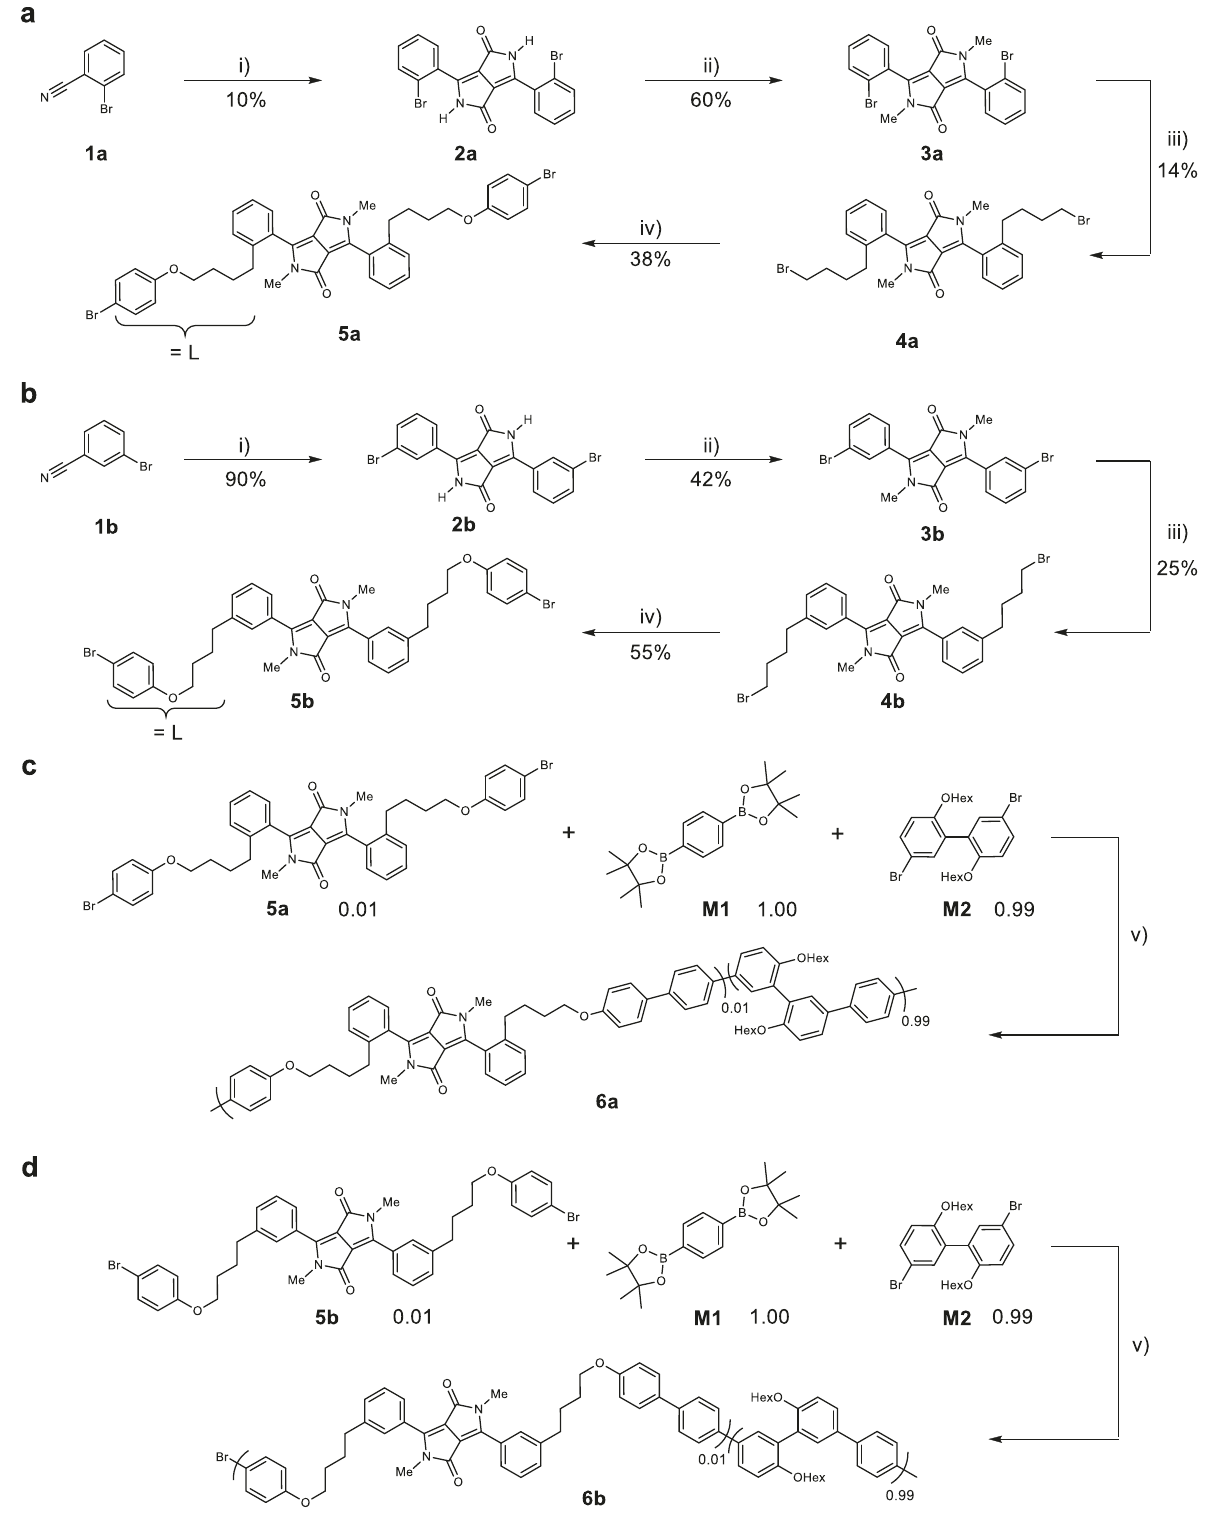
Fig. 4 Synthesis route of the DA torsional springs. a , b Synthesis of o -LBrPhDPP ( 5a ) and m -LBrPhDPP ( 5b ) with L = phenoxybutyl. c , d Incorporation of 5a and 5b into the polyphenylene matrix to o -DPP-P mmp P ( 6a ) and m -DPP-P mmp P ( 6b ). Reaction conditions: (i) diisopropylsuccinate, NaO t -Am, FeCl 3 , t - AmOH, 100 °C, 15 h; (ii) Me- p -Tos, K 2 CO 3 , DMF, 120 °C, 3 h; (iii) 4-bromobutylzinc bromide (in situ), Pd 2 (dba) 3 , SPhos, DMAc, 80 °C, 2 h; (iv) 4- bromophenol, K 2 CO 3 , DMF, 50 °C, 16 h; (v) Pd 2 (dba) 3 , SPhos, Aliquat 336, toluene/2M K 2 CO 3 (aq), 70 °C, 24